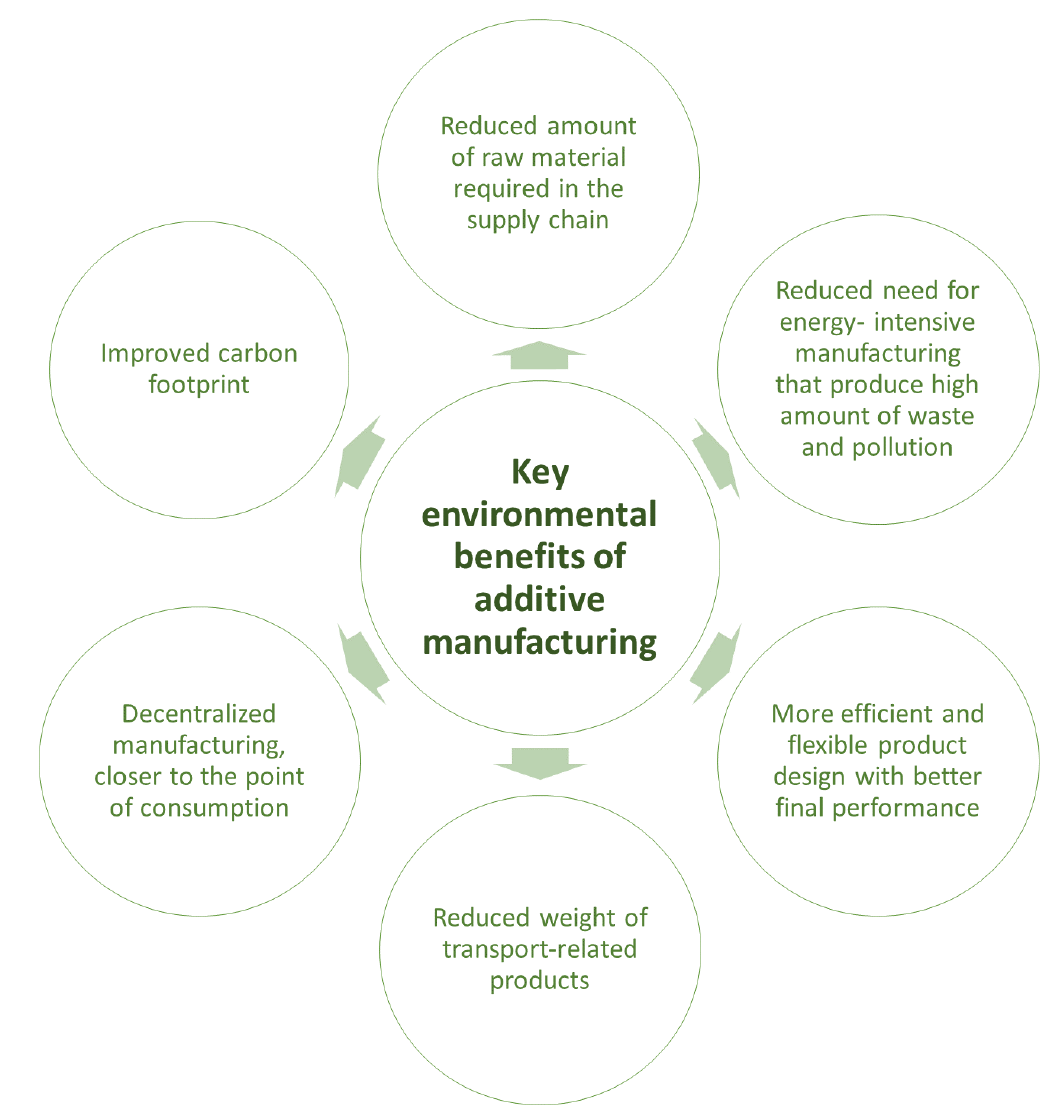
Figure 3. Environmental benefits of additive manufacturing.